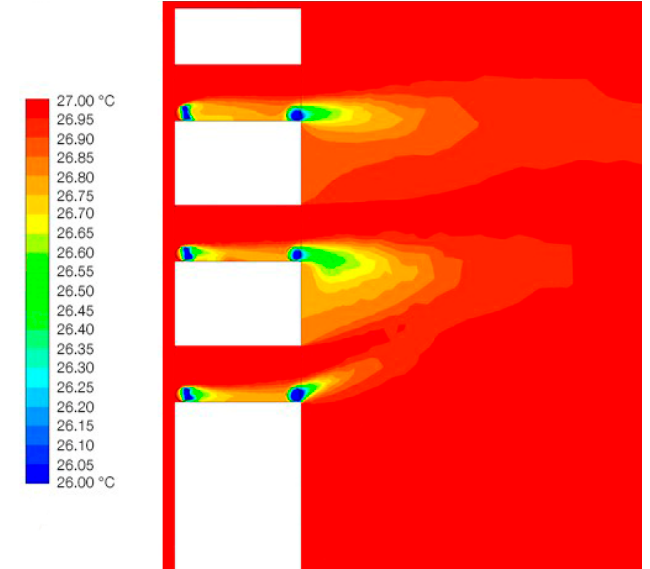
Figure 20. Air temperature around the sky garden with reduced inlet velocity.